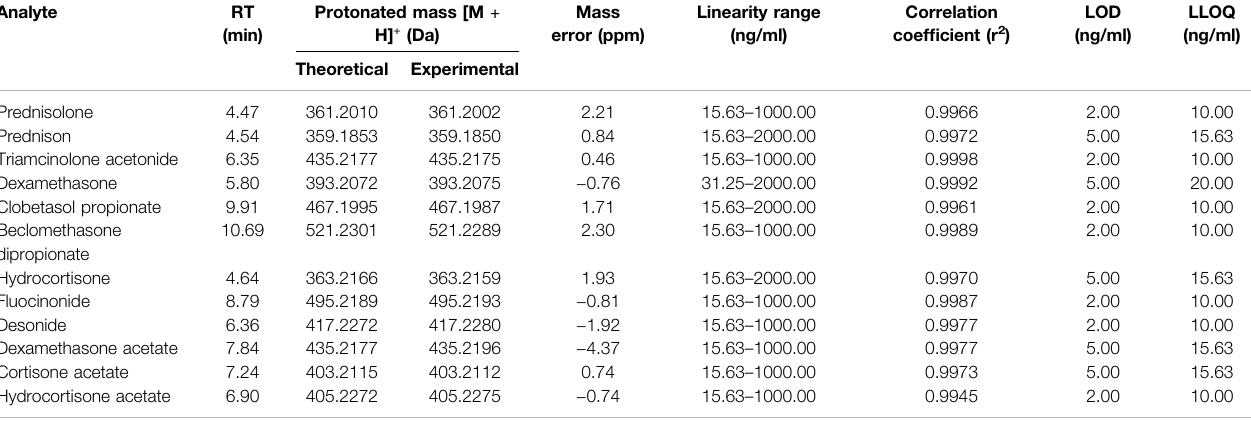
TABLE 1 | Retention time, molecular formula, accurate mass, linearity, and sensitivity of 12 illegal adulterated glucocorticoids obtained by UHPLC-QTOF-MS. Analyte